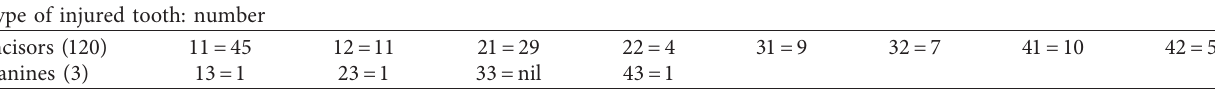
Table 2: Distribution of dental trauma according to affected tooth type.